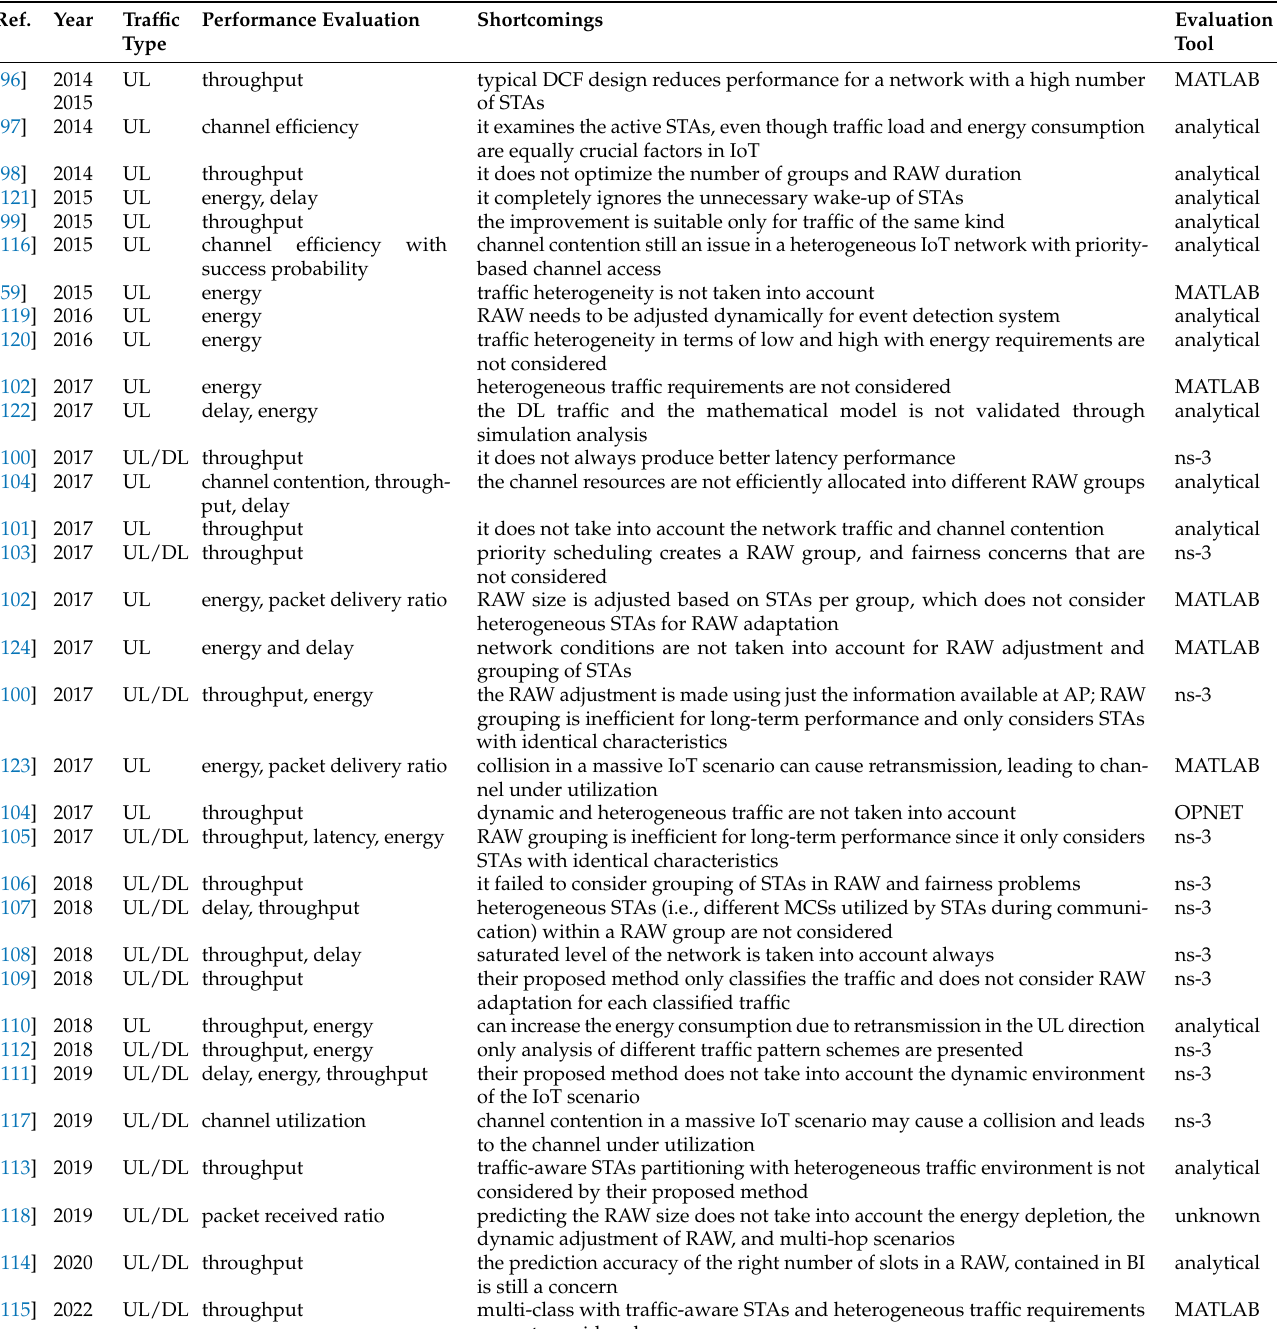
Table 5. Current solutions on RAW optimization of the IEEE 802.11ah WLAN with